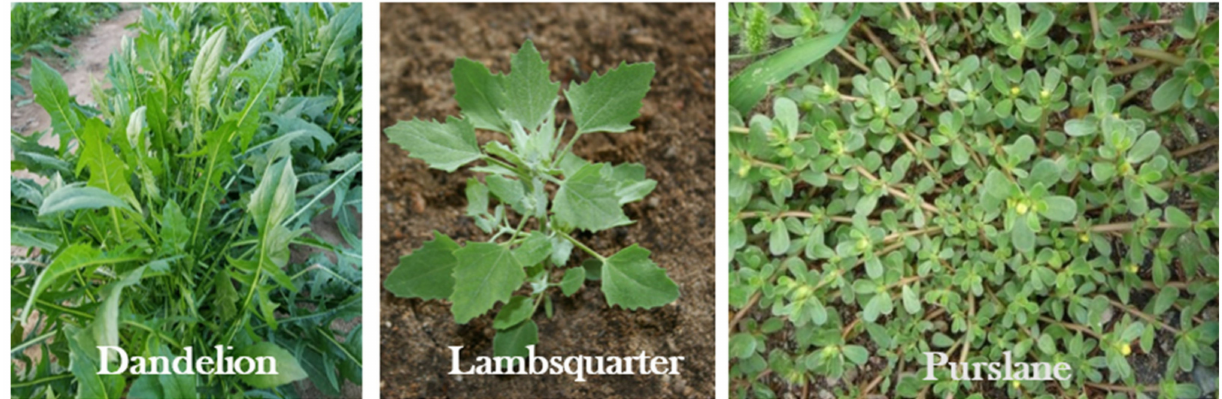
Figure 2. Some ethnic leafy greens cultivated at Specca Farms Pick-Your-Own, Bordentown, New Jersey. These crops are common weeds in the United States but eaten by many ethnic